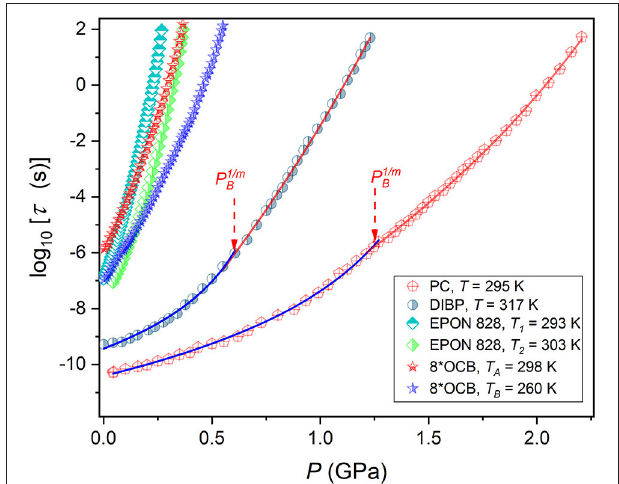
FIGURE 1 | Pressure dependences of the primary relaxation time for tested glass forming systems. Experimental data are portrayed by Equation (15), with parameters given in Table 2 . Note the manifestation of the dynamic crossover phenomenon (different colors matched of portraying curves), associated with changes of values in Equation (15). Temperatures related to tested isotherms are